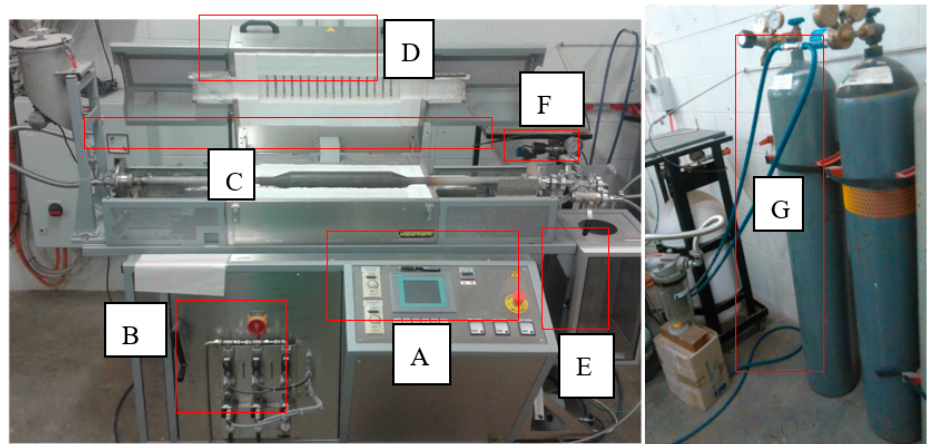
Figure 1. Photo of the rotary kiln (Nabertherm, Lilienthal, Germany). ( A ): Control panel, ( B ): Mass flow controllers, ( C ): Stainless steel tube, ( D ): Heating element, ( E ): Material collection jar, ( F ): Thermocouple connection, ( G ): Nitrogen cylinder. Th rotary kiln was used for the heat-activation of dunite and lizardite. It was also used for the dunite heat-transformation.